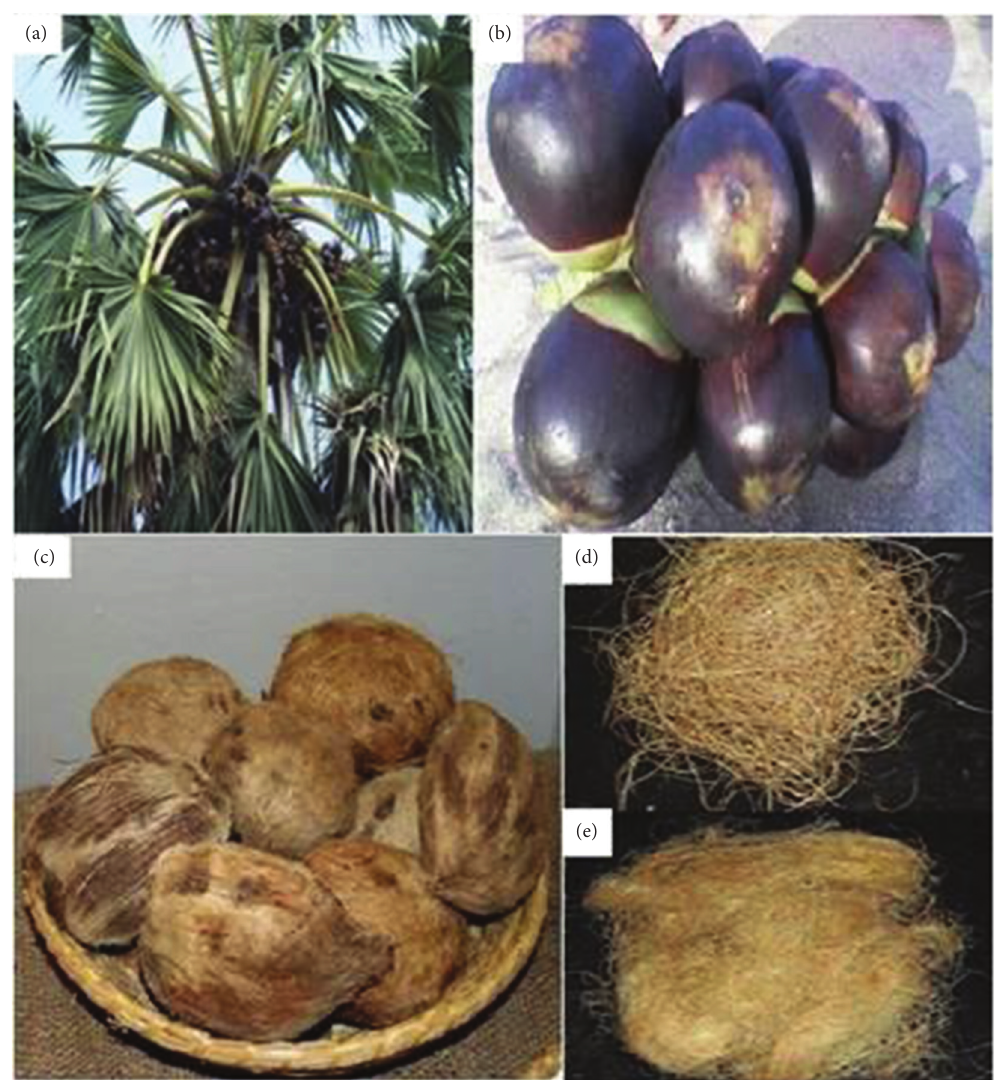
Figure 3: (a) Borassus tree, (b) natural products, (c) dried organic products, (d) Borassus natural product coarse filaments, and (e) fine strands [28,